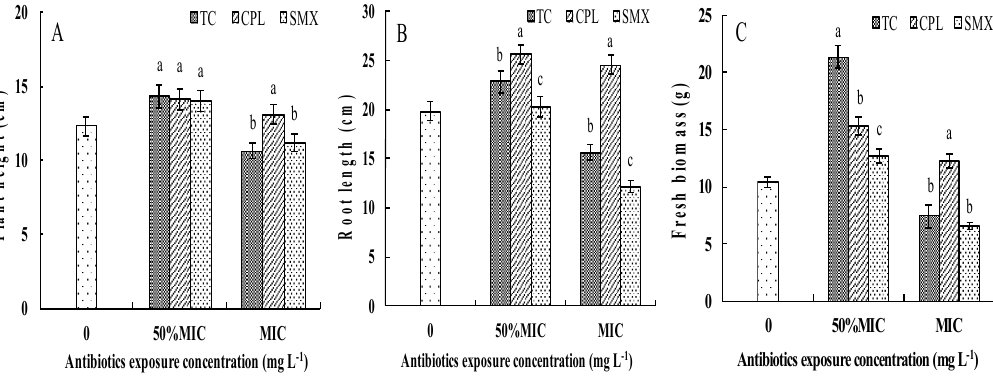
Figure 1. Effects of different dosages and types of antibiotic exposure on the growth of pakchoi under hydroponic condition. ( A ) Plant height; ( B ) Root length; ( C ) Fresh biomass. Values are mean ± SD ( n = 10). Different letters on the top of the error bars indicate statistically difference among the treatments ( p < 0.05). TC, tetracycline; CPL, cephalexin; SMX, sulfamethoxazole; MIC, minimum inhibitory concentration; SD, standard deviation.